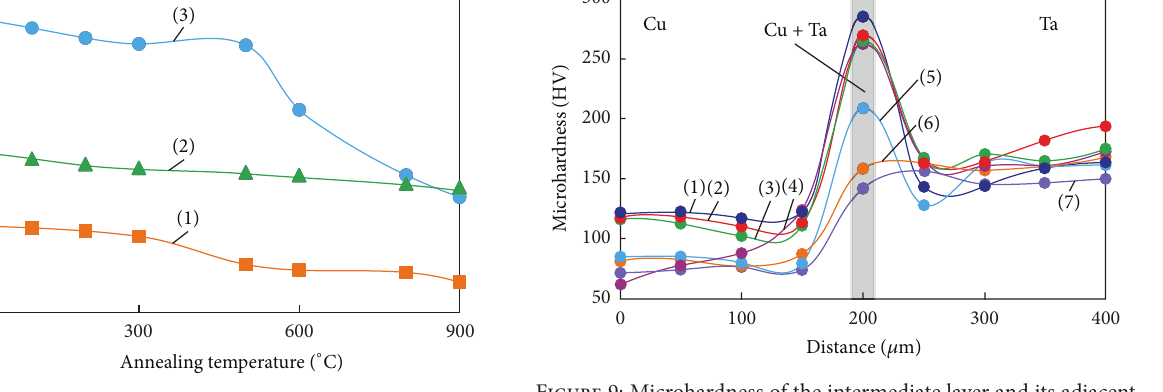
Figure 8: Effect of heating temperature on the microhardness of copper (1), tantalum (2), and the intermediate layer with a heterophase structure (3).